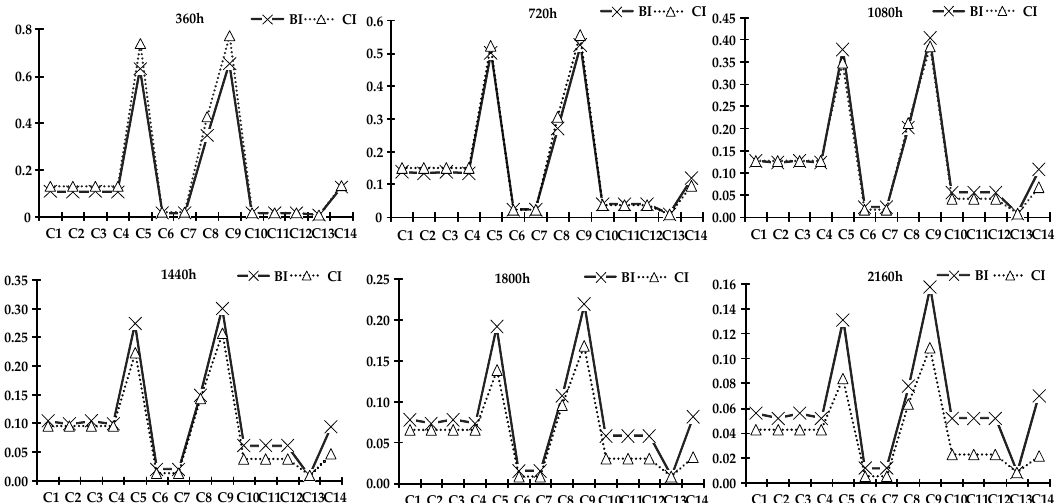
Figure 11. Importance levels of components when quota ratio of P N and P out are fixed .